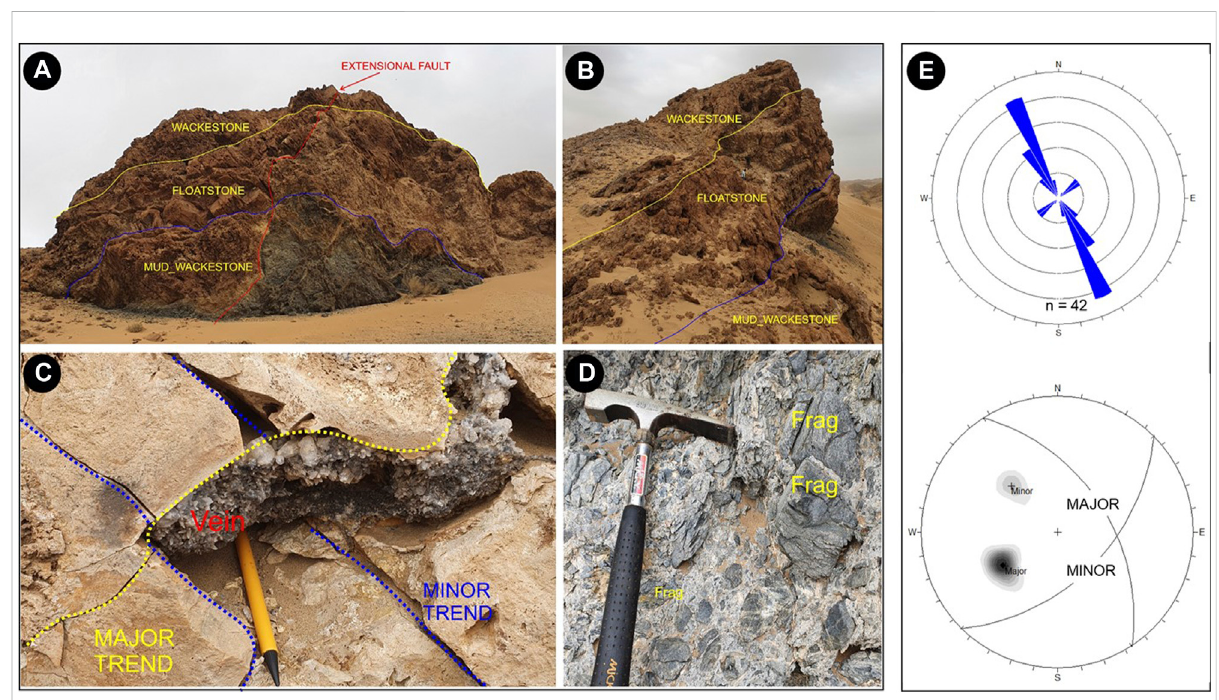
FIGURE 2 Outcrop image of the study area. (A) Three different facies are observed: lowermost mud-wackestone, middle coralline fl oatstone, and uppermost wackestone. The red line points to an extensional fault. (B) Outcrop image from a different angle shows 30 – 40 ° dipping to the NW. (C) Two dominant fracture trends: major (yellow dash line) and minor trend (blue dash line), with partial dog tooth-shape vein fi lling. (D) Breccia zone consists of sidewall carbonate fragments (Frag: Breccia fragment). (E) Top picture is a rosette diagram of kinematic vein analysis in the study area. The bottom picture is the bed plane in a contour plot showing the major trend of both major and minor vein ’ s strike and dip